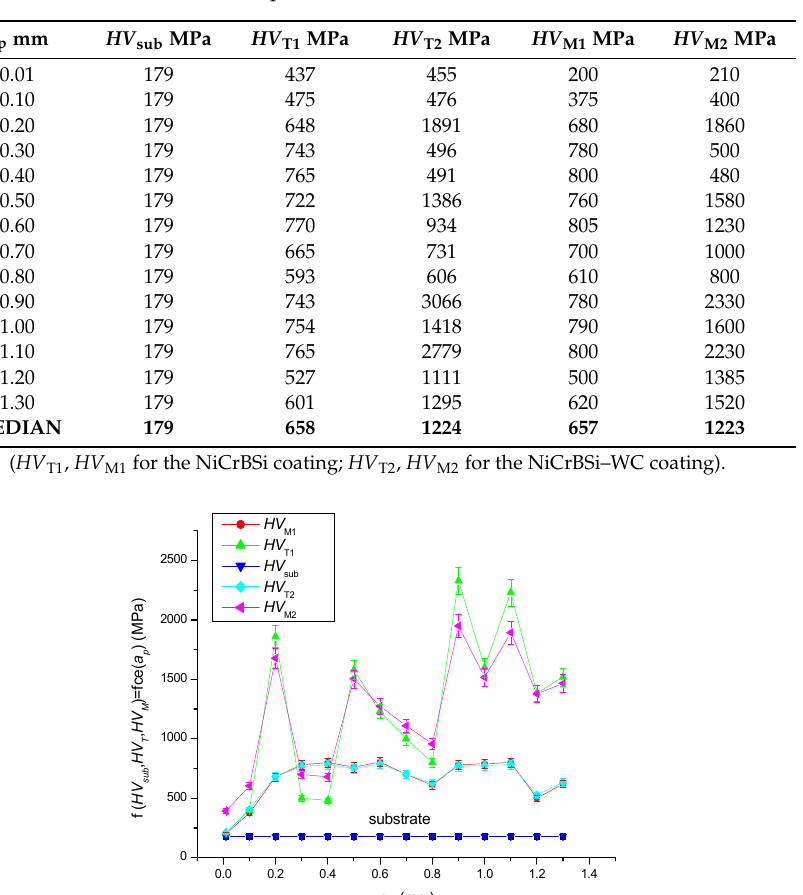
Table 4. Numerical comparison and verification of Vickers hardness.